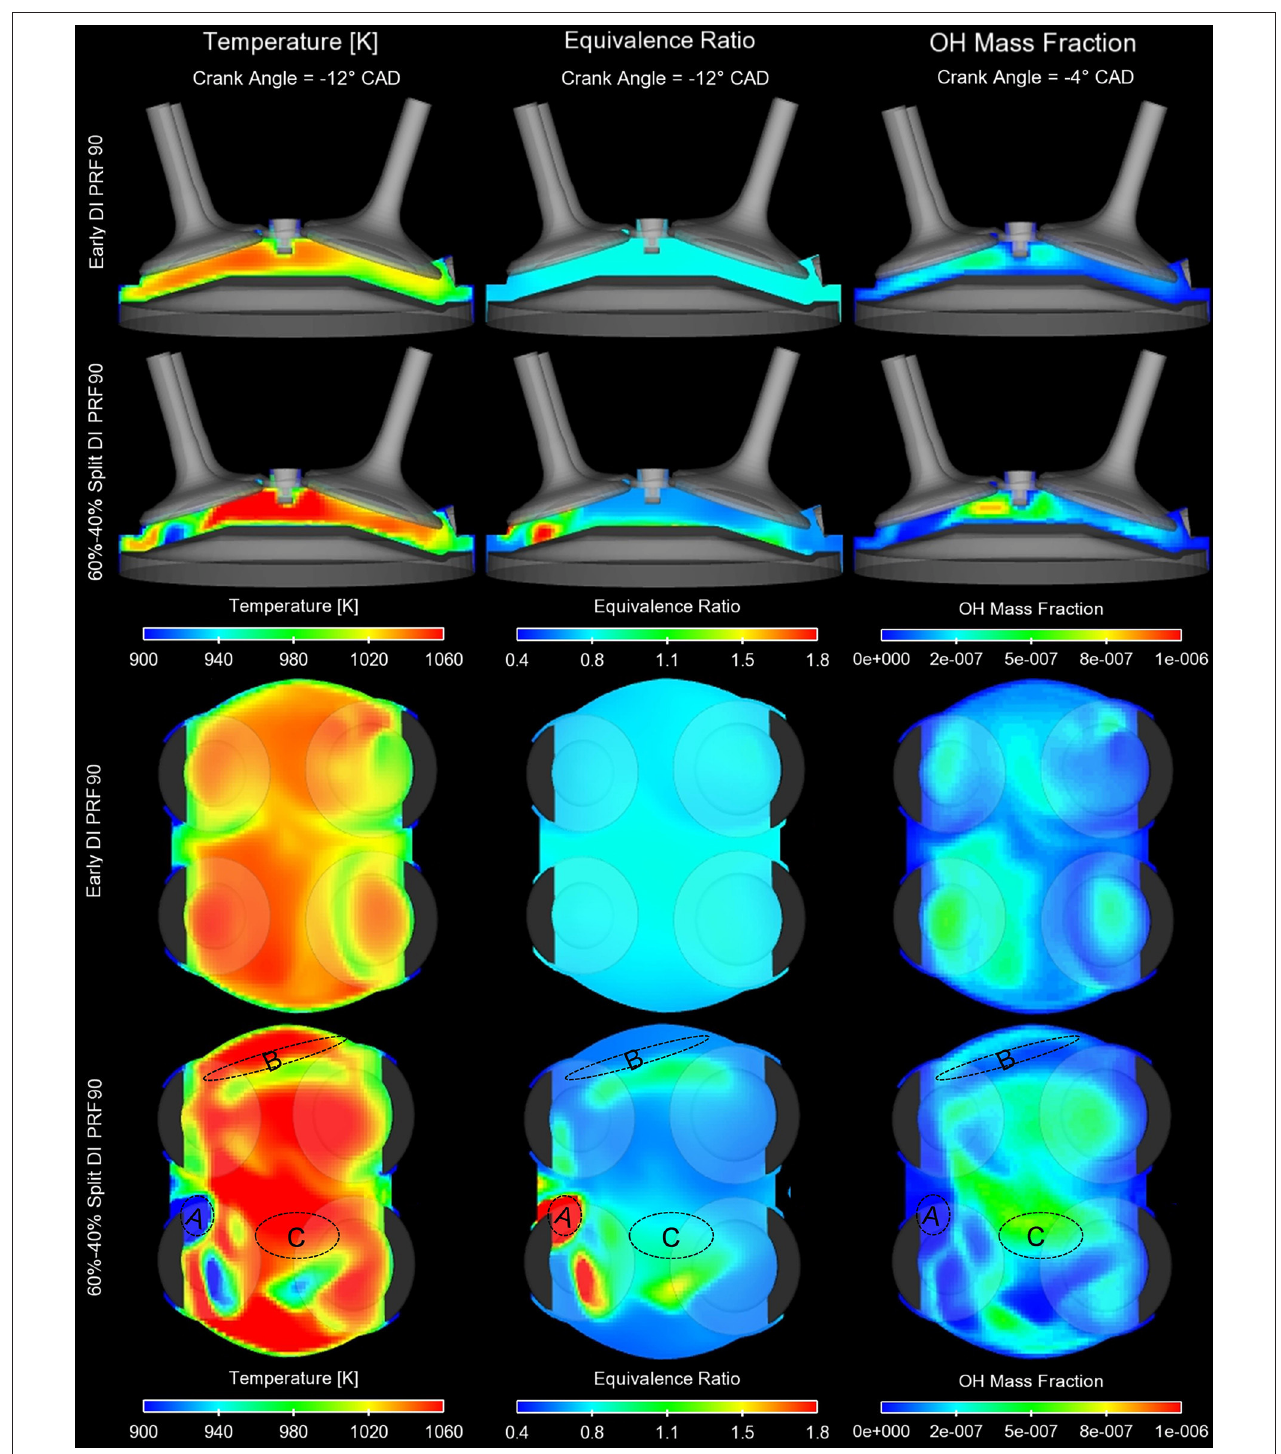
FIGURE 8 | PRF90: Vertical and horizontal cut-planes of temperature, equivalence ratio, and OH mass fraction distributions for the early DI and 60–40% split DI cases. The temperature, equivalence ratio, and OH mass fraction distributions are fairly uniform for the early DI case; while for the 60–40% split DI case, these distributions are stratified due to the direct fuel injection. Also, it is clear that the OH mass fraction distribution is governed by both the temperature and the equivalence ratio distribution and they compete with each other to dictate the autoignition of PRF90.